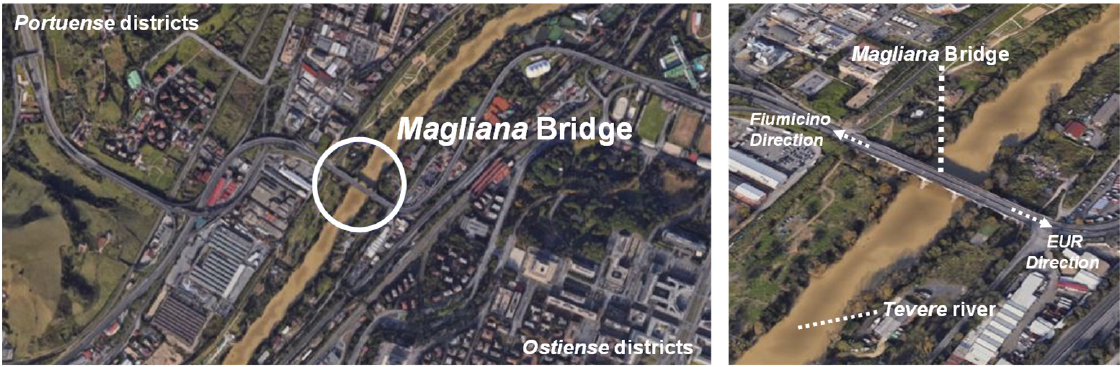
Figure 3. Overview and zoom of the “ Ponte della Magliana ” bridge in the urban context.